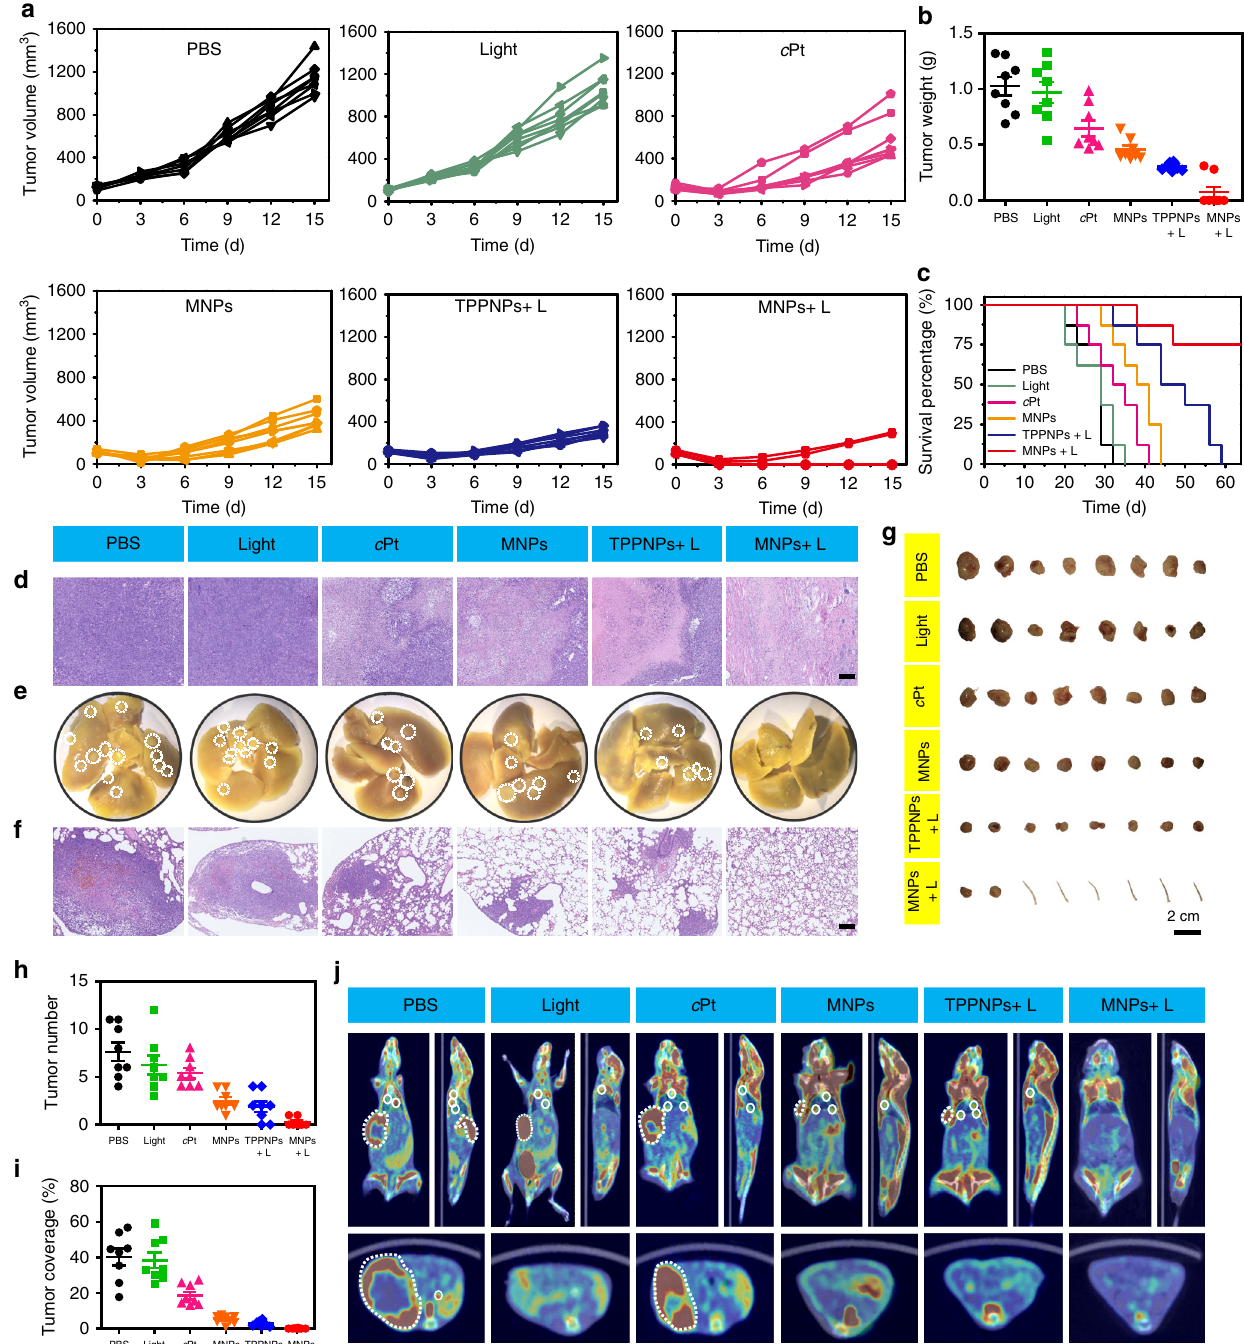
Fig. 8 Treatment of orthotopic breast cancer and inhibitory effects on lung metastasis. a Tumor volume changes of the mice treated with PBS, light, c Pt, MNPs, TPPNPs + L, or MNPs + L after one injection ( n = 8). b Tumor weight of the mice treated with different formulations. c Kaplan – Meier survival curves of the mice bearing orthotopic 4T1 breast tumors treated with different formulations. d H&E staining of the tumor tissues from each group. Scale bar is 500 μ M. e Representative images of the lungs excised from each group. The white circles denote the visually detected metastatic nodules in each lung tissue. f Histological examination of metastatic lesions in lung tissues from each group after H&E staining. Scale bar is 500 μ M. g Photo images of the orthotopic tumors harvested from the mice treated with different formulations. Mice tails indicate no tumor founded. h The numbers of tumor nodules present in the lungs from each group. i Tumor coverage percentage in the lungs from each group. j PET/CT images of the mice treated with different formulations at the 14th day post injection. The white dash circles denote the orthotopic breast tumors, and the white solid circles denote the metastatic tumors. The laser density was 0.3 W cm – 2 at 671 nm, and the irradiation time was 10 min. The data are expressed as means ± s.d., *** P <